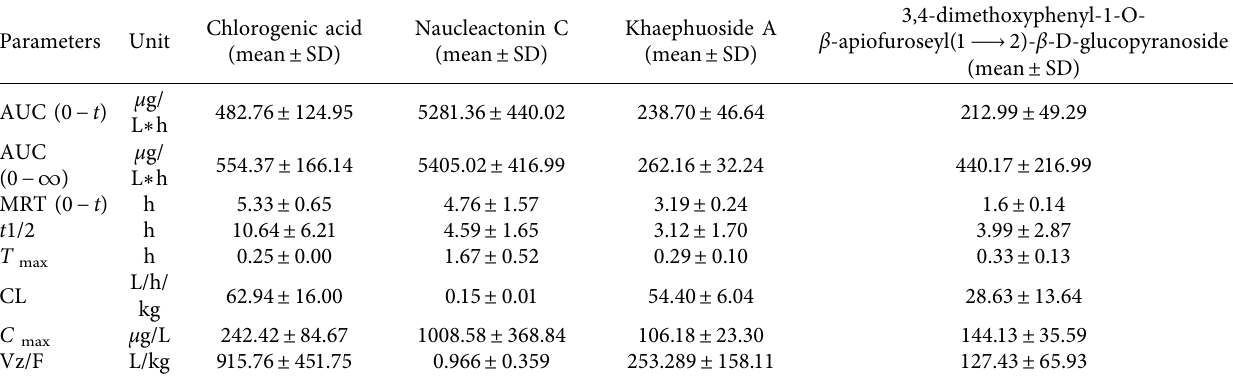
Table 6: Summary of primary pharmacokinetic parameters of four analytes ( n � 6).